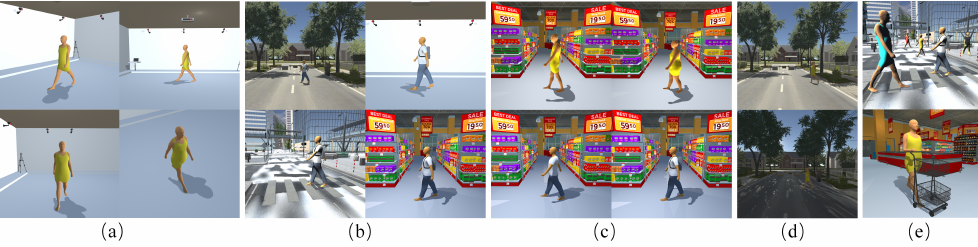
Figure 4. Variation of factors: ( a ) viewpoint variation; ( b ) scene variation; ( c ) appearance variation; ( d ) lighting variation; ( e ) extreme